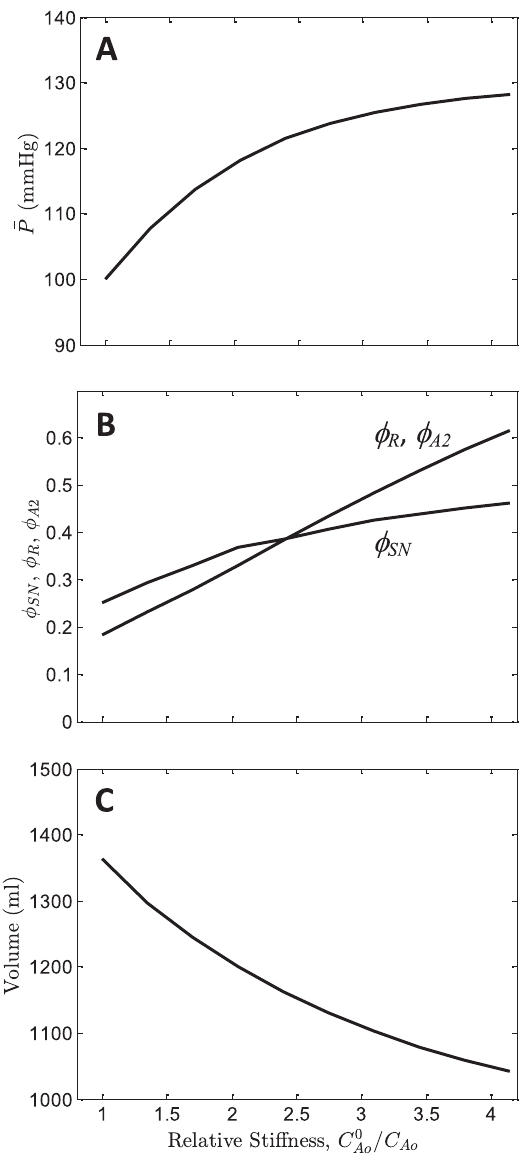
Figure 10. Effects of arterial stiffening on mean pressure. A . The model predicted for the steady-state mean arterial pressure is plotted as a function of relative aortic stiffness, C the baseline normal value of aortic compliance, and C used to obtain the simulated pressure. As stiffness is increased (as compliance is decreased), predicted mean pressure increases. Calculations assume normal salt/volume loading, Q min -1 , resulting in a mean pressure of 100 mmHg at C Model-predicted steady-state sympathetic tone φ activity φ , and angiotensin-II activity φ R 0 / C of C . C . Predicted blood volume is plotted as a function of Ao Ao 0 / C C Ao Ao